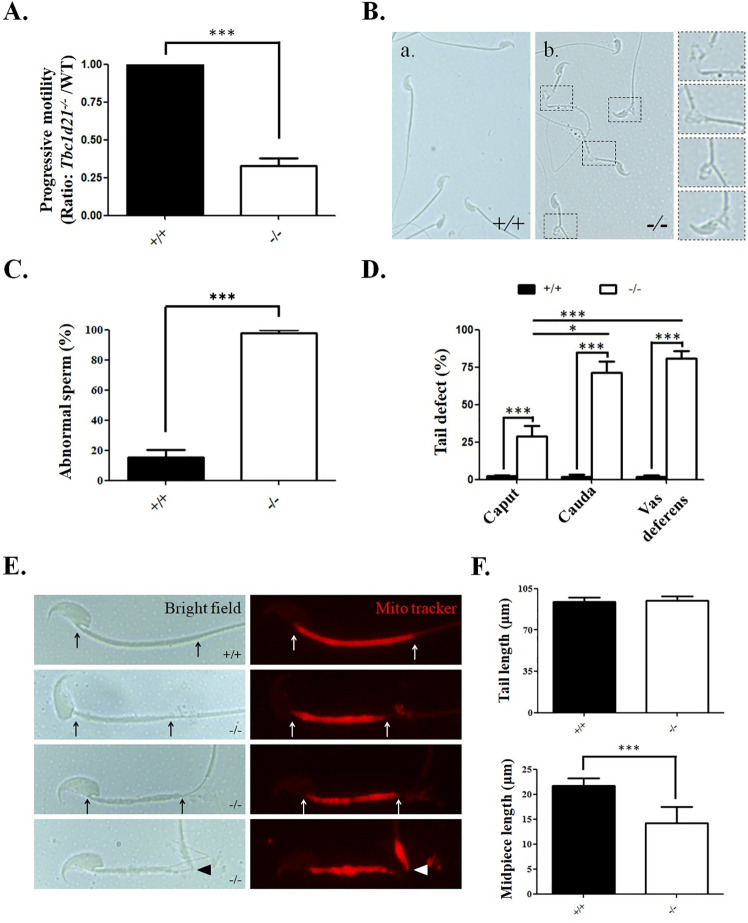
Knockout of Tbc1d21 in mice causes sperm tail defects.(A) Sperm collected from 2-month-old wild-type and Tbc1d21-deficient mice. Analysis of the ratio of sperm with progressive motility in Tbc1d21-/- mice, which were normalized to the wild-type mice to calculate the fold change. (B) Sperm collected from Tbc1d21-/- mice had a defective tail (b), compared with the wild-type (a). Enlarged figures of the defective tail at the left panel represents the back-dot square of (b). (C) The statistical analysis showing the ratio of abnormal sperm isolated from wild-type and Tbc1d21-/- mice. (D) Statistical analysis representing the percentage of tail-defective sperm, collected from the caput of the epididymis, cauda of the epididymis, and the vas deferens. (E) The figures show the disrupted morphology of the midpiece region (between the arrows or arrowhead indicated) of Tbc1d21 deficient sperm compared to sperm from wild-type mice (Left panel: Bright filed; Right panel: staining with Mito-tracker). (F) The statistical analysis represents the length of the sperm tail and midpiece of wild-type and Tbc1d21-/- mice. Each bar represents the mean ± standard error of the mean (SEM); Mice number (n = 3) per genotype. Sperm number >100 per mice. *Significant differences compared with the wild-type mice (***p < 0.0001, analysed using Student's t test).